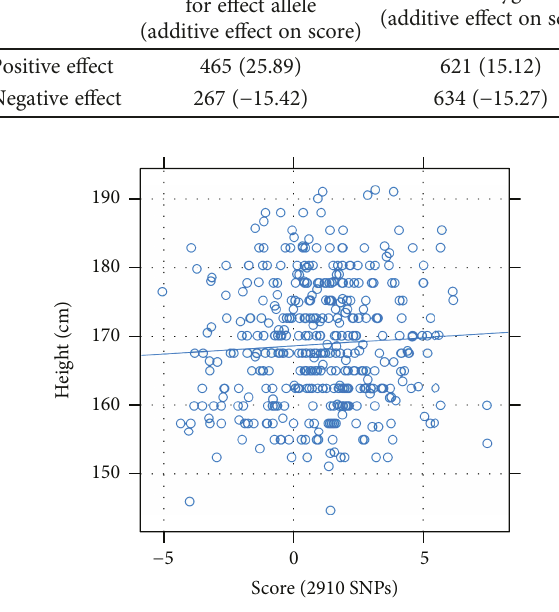
Figure 3: Correlation between height scores and self-reported height in the ADNI and Cache County individuals. We plotted height scores and self-reported heights (at age 18) for individuals in the ADNI and Cache County datasets and found poor correlation between the two. We also calculated the Pearson product moment correlation coe ffi cient (correlation coe ffi cient=0.06, p = 0 25